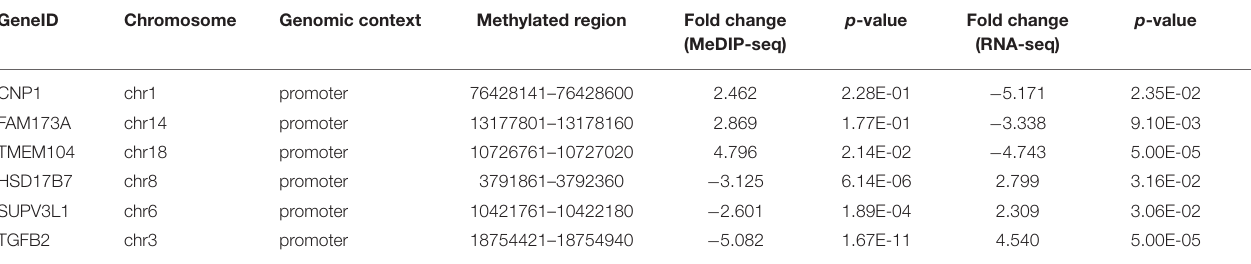
p -value Fold change p (MeDIP-seq) (RNA-seq)